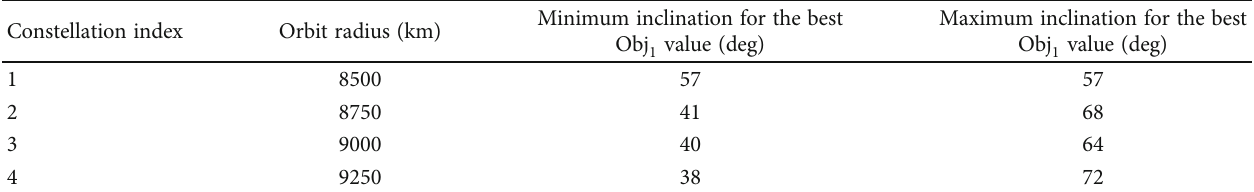
Table 1: Navigation performance of the four con fi gurations.